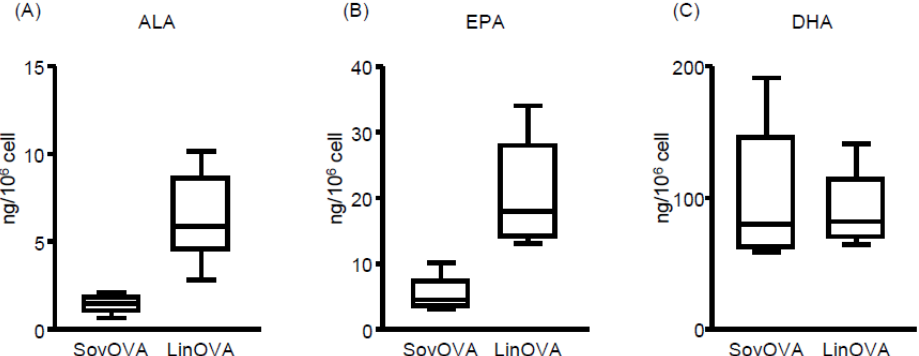
Figure 2. Dietary fatty acid is reflected in the fatty acid composition of the nasal passages of mice. ( A – C ) The OVA-induced allergic rhinitis model was applied to mice maintained on a diet containing 4% soybean oil (Soy) or linseed oil (Lin). Mice were challenged intranasally with OVA. Cells were collected from nasal passages, and the levels of ( A ) alpha-linolenic acid (ALA), ( B ) eicosapentaenoic acid (EPA), and ( C ) docosahexaenoic acid (DHA) in the cells were analyzed by using liquid chromatography coupled with tandem mass spectrometry (LC–MS / MS). Data are from two independent experiments ( n = 7). Center values indicate medians.